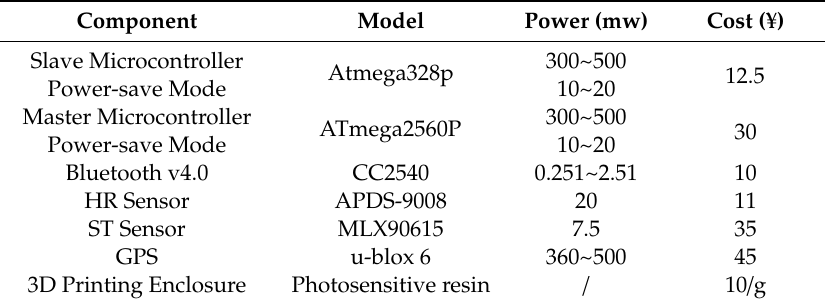
Table 3. Main component power consumption and cost